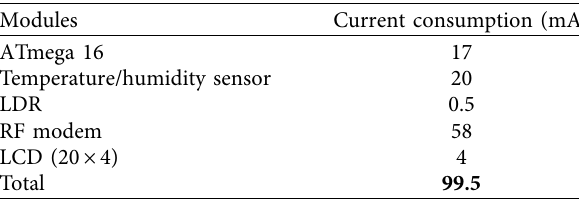
Te bold is made to show the total value of current in Table 11. Table 12: Consumption of current for remote control. Components Current consumptions (mA) ATmega 16 Tree dimmers RF modem LCD (20 × 4) 4 Total 54